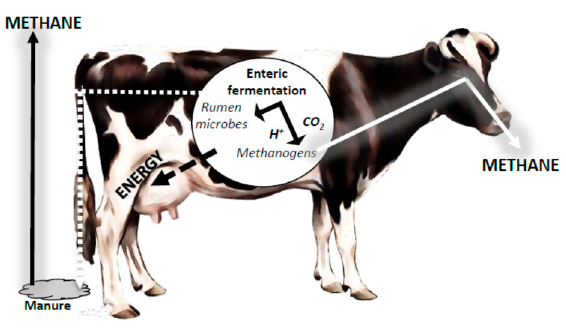
Figure 2. Schematic image of the in situ nylon bag technique (adapted from Berean et al., 2015 [13]).